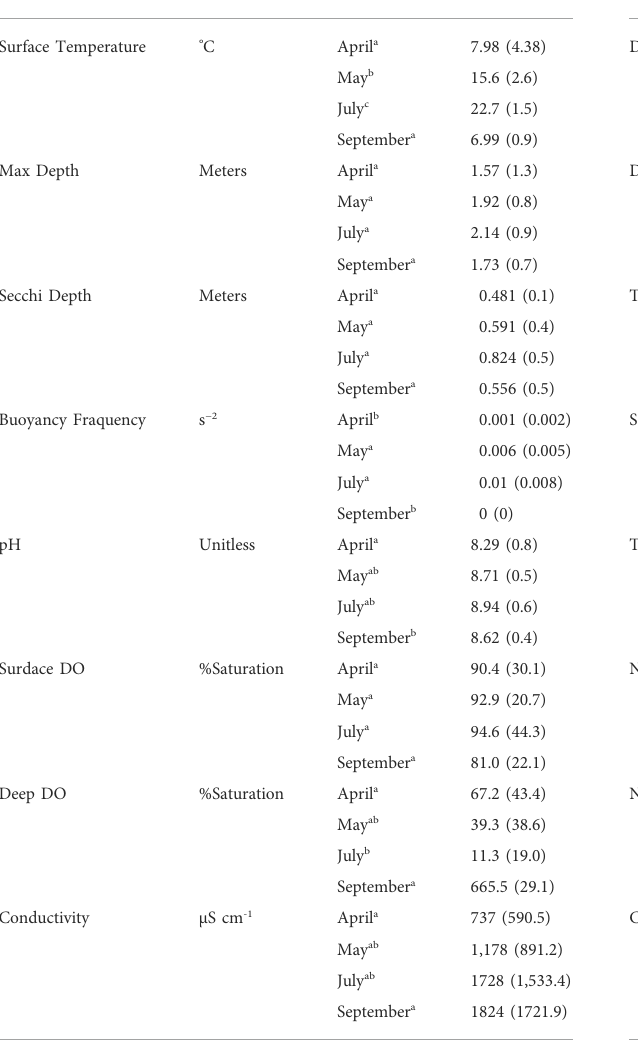
TABLE 1 Physical and environmental parameters measured in the 20 reservoirs monthly in 2018. All parameters, excluding max depth, Secchi depth, and buoyancy frequency were measured using the YSI multi-parameter probe at 0.5 m below the water surface, excluding deep dissolved oxygen which was taken 0.5 m above the sediment. Presented as mean ± standard deviation (SD). Superscript letters denote signi fi cant differences between monthsbasedonANOVAandpost-hocTukeytest.DO=Dissolved Oxygen.